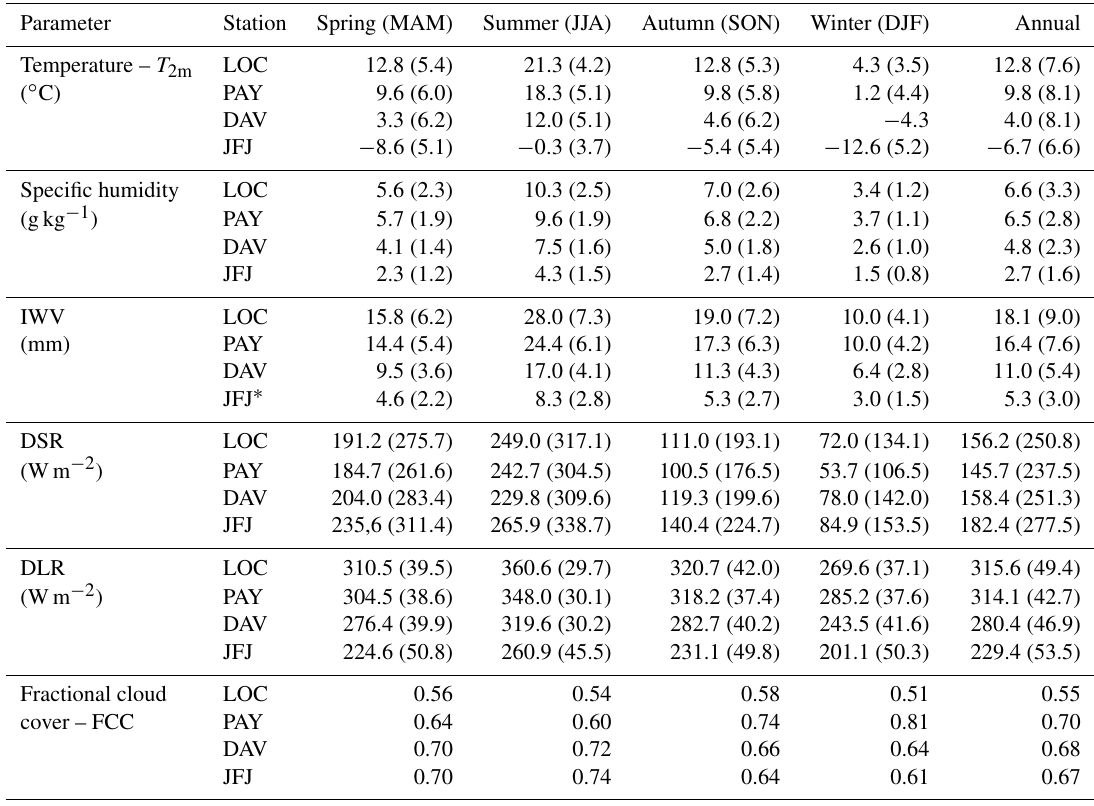
Table 1. Summary of selected parameters during all-sky conditions for the 1996–2015 period at the four SACRaM stations (ordered by ascending altitude: LOC = 367m, PAY = 491m, DAV = 1594m, and JFJ = 3580m). Average values constructed from 10min data are shown with the standard deviations in